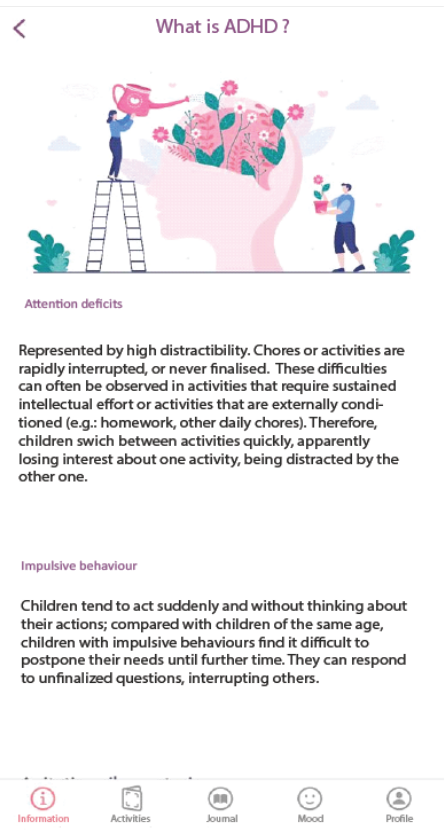
Figure 1. Psychoeducation about ADHD Module.